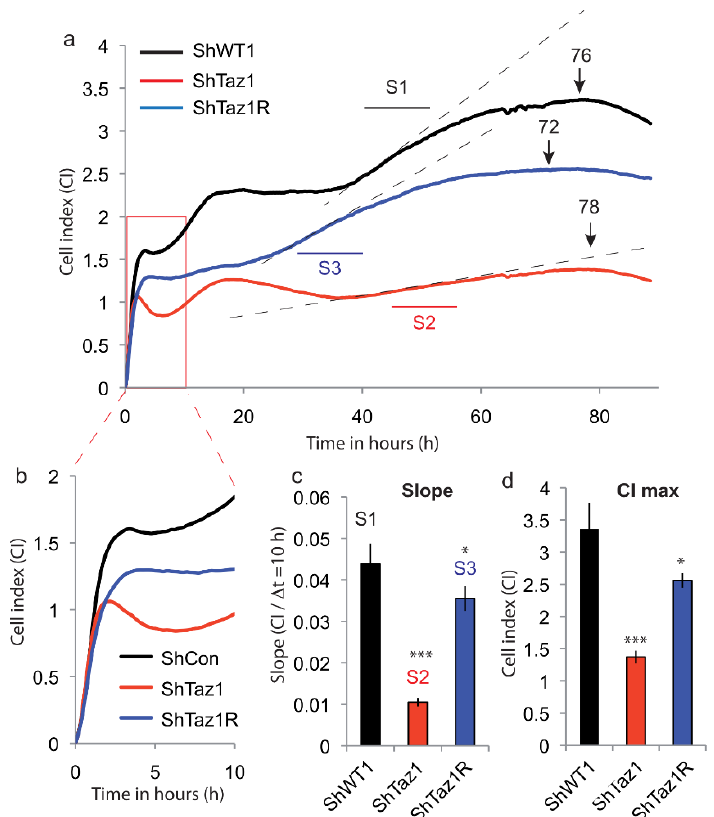
Figure 4. Analysis of the cellular proliferation of the three lines (ShWT1, ShTaz1 and ShTazR1) by impedancemetry with the Xcelligence system (ACEA, Invitrogen). ( a ) The histogram represents the cell index (CI) versus time of proliferation (in h) of the three cell lines ShWT1, ShTaz1 and ShTaz1R. S1 to S3 are the slope measurements over 10 h for each proliferation curve. SWT1 in black, ShTaz1 in red and ShTaz1R in blue. The number on the top of the curve indicates the number of hours needed to reach peak proliferation for each cell line. ( b ) Cellular enlargement and the early phase of cell adhesion to the bottom of the wells for the three cell lines. ( c ) Histogram representation of the slope of cellular proliferation of the three cell lines. The slope is given as CI / ∆ t (recorded over ten hours between 50 and 60 h of cell culture). ( d ) Histogram representation of the maximum CI reached by the three cell lines at their peak proliferation. CI is in arbitrary units (a.u.). * is the p -value ≤ 0.05 and *** is the p -value ≤